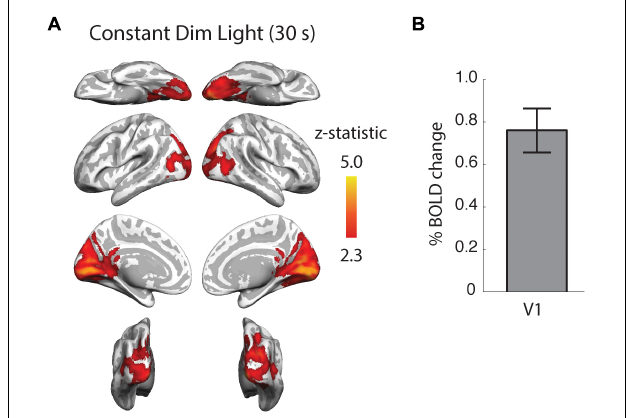
FIGURE 5 | Neural activity in response to constant dim light compared to darkness in 13 healthy, sighted female participants. This weak light stimulus evoked extensive activity across the occipital cortex (A) including a significant response in primary visual cortex, V1 (B) . Data replotted from Bridge et al.